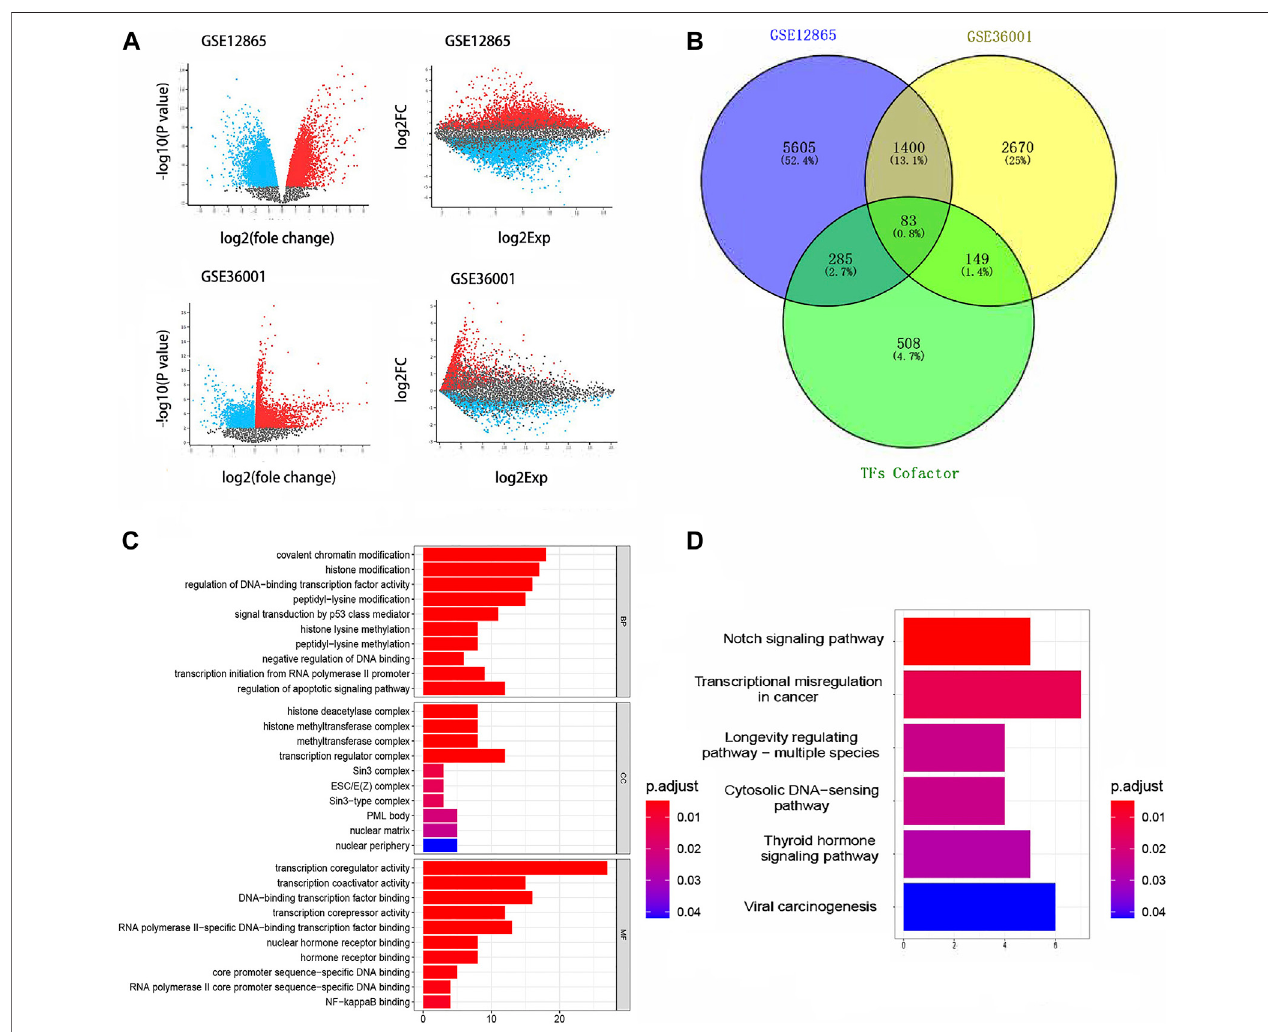
FIGURE2| Resultsofdifferentialgeneanalysis. (A) DifferentiallyexpressedgenesinGSE36001andGSE12865. (B) 83differentiallyexpressedTcoF-relatedgenes were screened from differentially expressed genes. (C) GO bar graph for genes in BP, CC, and MF. (D) Result of the KEGG pathway enrichment analysis. GO, Gene Ontology; KEGG, Kyoto Encyclopedia of Genes and